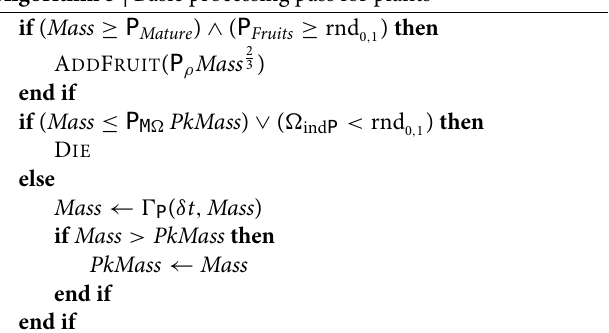
Algorithm 5 | Basic processing pass for